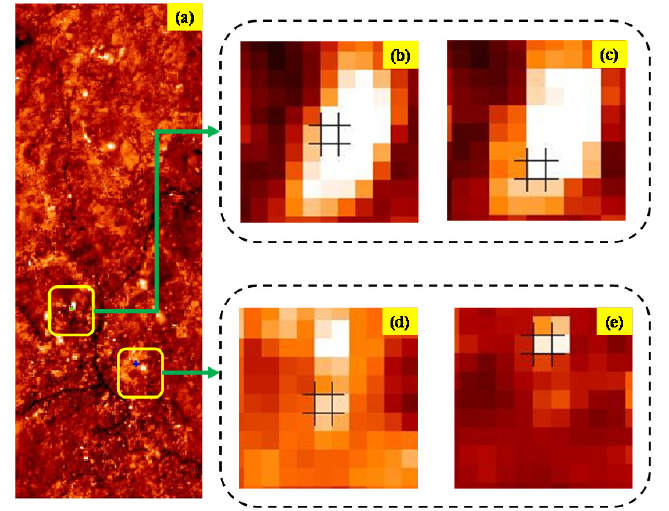
Figure 12. Target detection score image from ( a ) space-borne imagery using THI target reference spectra and the enlarged detection score footprint for ( b ) N3Y, ( c ) N4B, ( d ) N1G, and ( e ) N2R target.